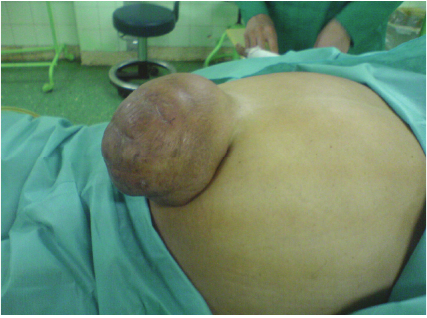
Figure 1: Umbilical cystic mass mimicking umbilical hernia.